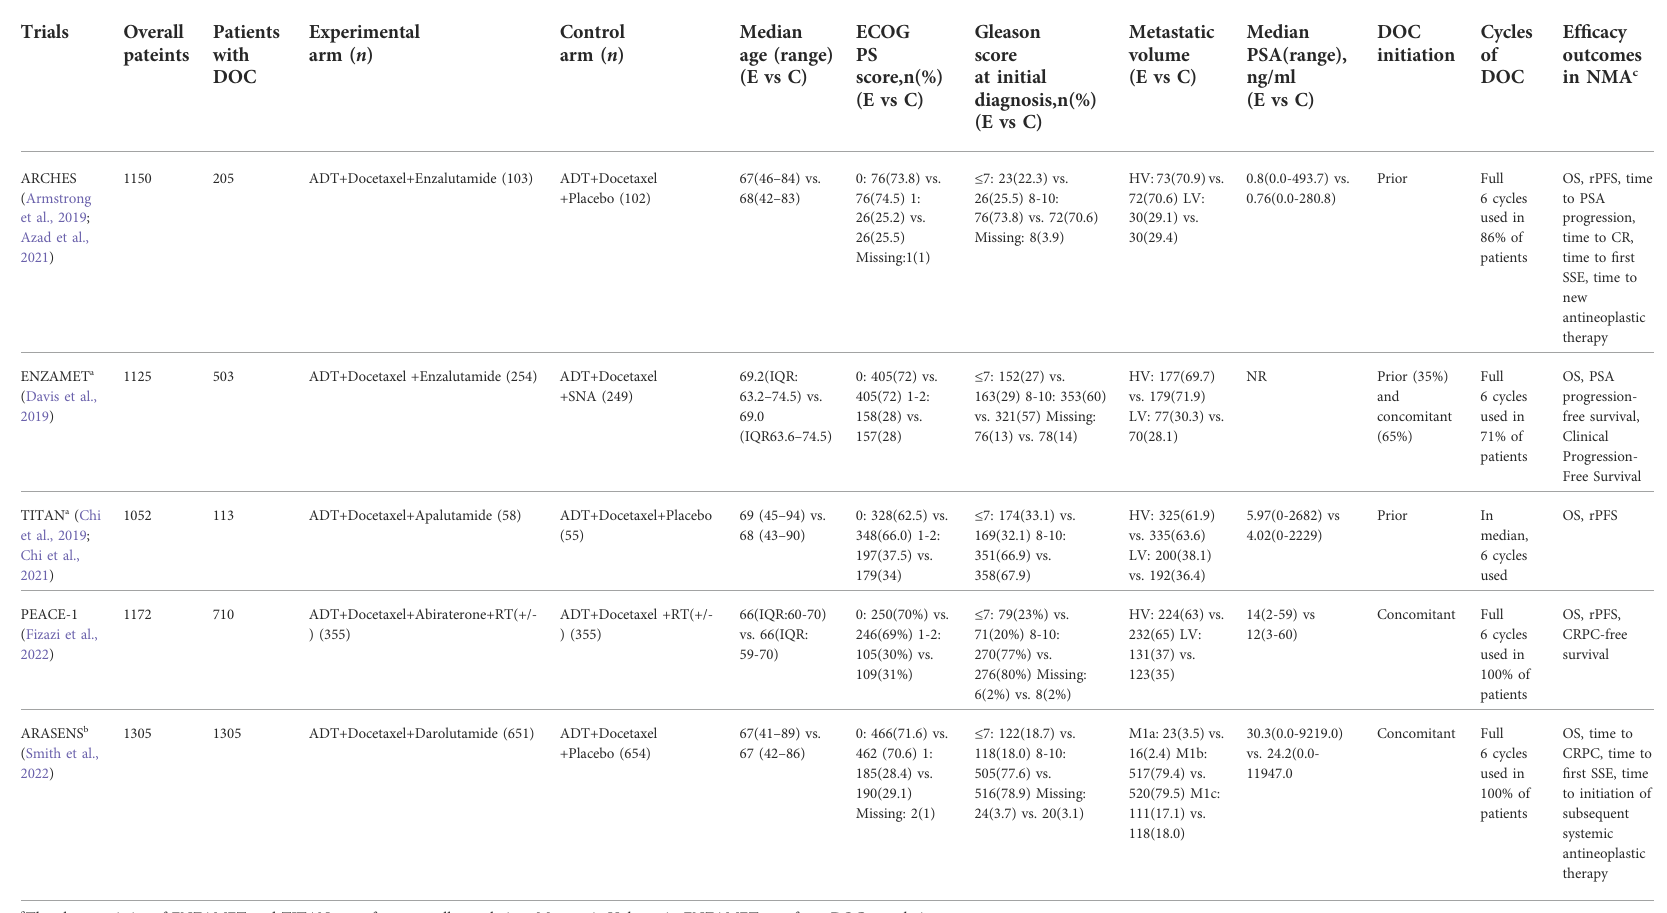
VersusPlaceboPlusADTinPatientsWithMetastaticHormoneSensitiveProstateCancer(mHSPC);C,ControlArm;DOC,docetaxel;ECOGPS,EasternCooperativeOncologyGroupPerformanceStatus;E,ExperimentalArm;ENZAMET,Enzalutamide in First Line Androgen Deprivation Therapy for Metastatic Prostate cancer; HL, high volume; LV, low volume; NR, not reported; OS, overall survival; PEACE-1, A Phase IIIStudy for Patients With Metastatic Hormone-natïve Prostate Cancer; rPFS, Radiographic progression-free survival; RT, radiotherapy; SNA, standard nonsteroidal antiandrogen (bicalutamide, nilutamide or fl utamide); TITAN, Targeted Investigational Treatment Analysis of Novel